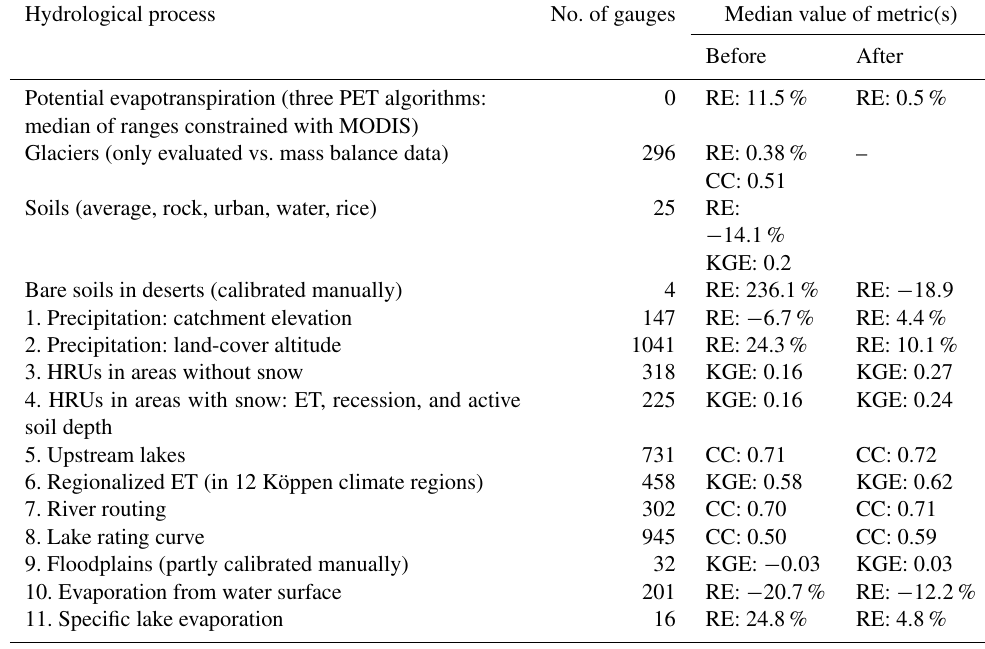
Table 6. Metrics of model performance before and after calibrating various hydrological processes simultaneously at a number of selected river gauges, using the stepwise parameter-estimation procedure globally. Parameter values and names in the HYPE model are given in the